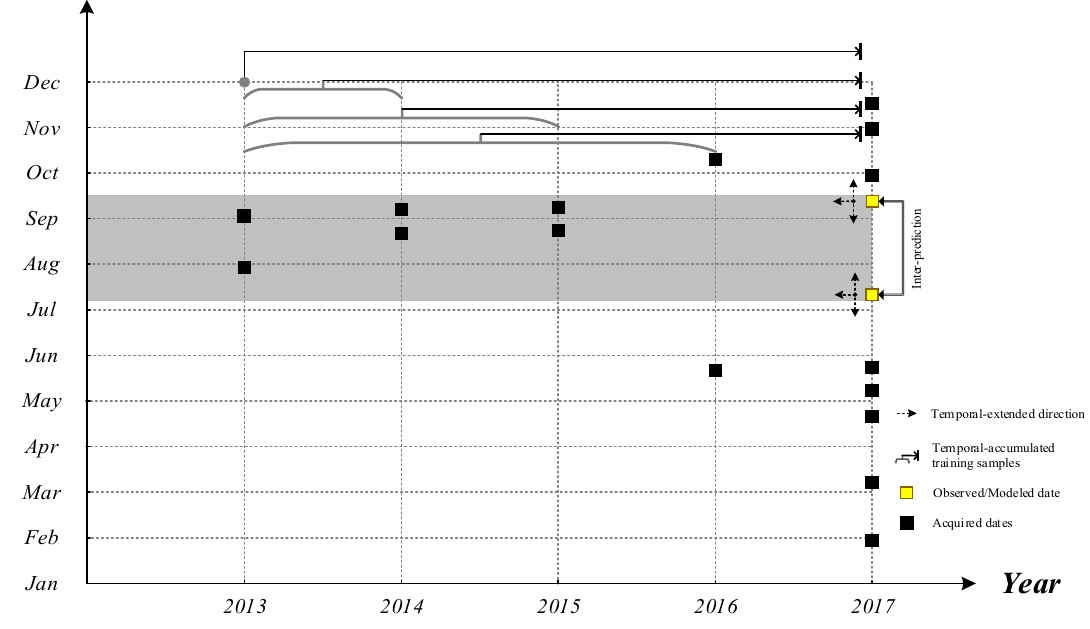
Figure 9. Proposed bi-directional fusion strategy with temporally extended training samples. Table 7. Assessment indices from the proposed fusion with the urban data acquired in 2017 for modeling reflectance on 10 July 2017.